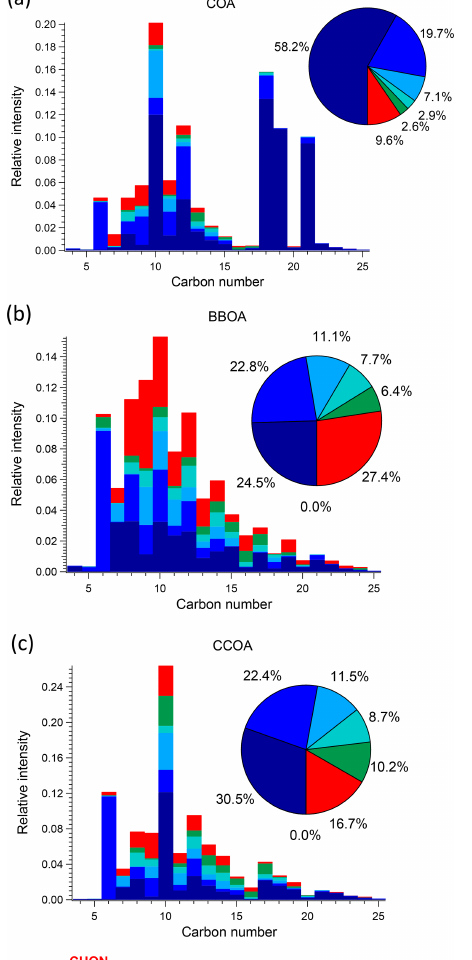
Figure 6. Carbon number distribution plots of three primary factors: (a) COA, (b) BBOA, and (c) CCOA, coloured by C x H y O z N 1–2 , and five different C x H y O z categories based on O:C ratio (O:C < 0.25, 0.25 < O:C < 0.45, 0.45 < O:C < 0.65, 0.65 < O:C < 0.85 and O:C > 0.85). Each distribution is nor- malised such that its sum is